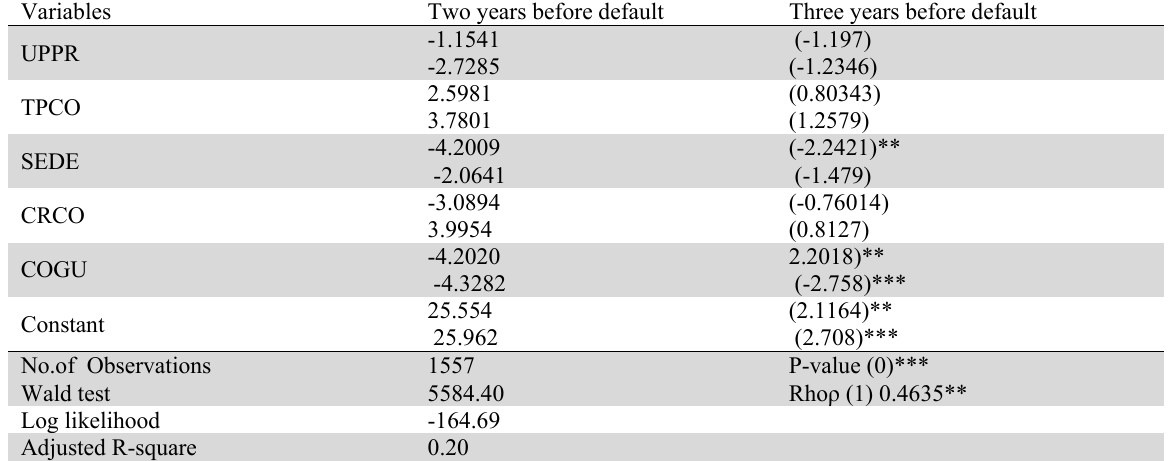
Estimated Coefficients for the Participation Model two and three years before